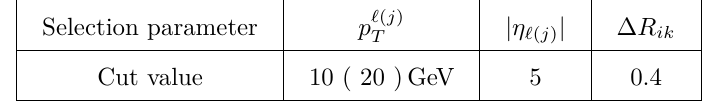
p ( η i − η k ) 2 + ( φ i − φ k ) 2 , where